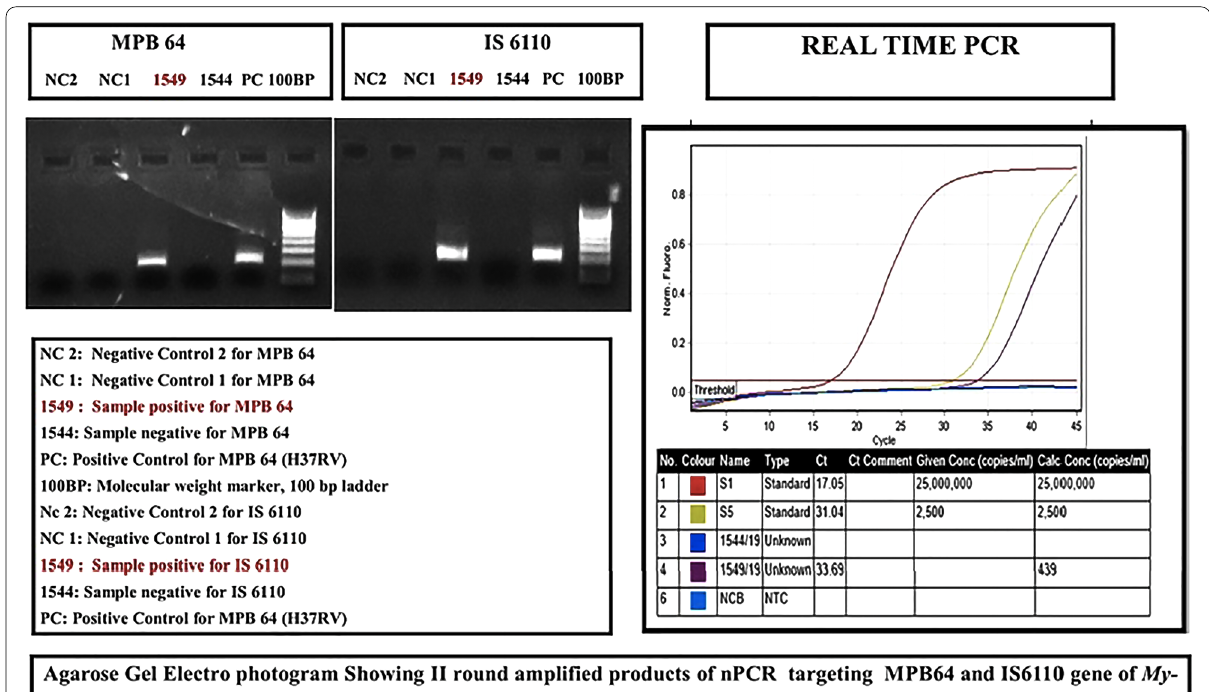
Fig. 4 Vitreous sample of a patient which showed positive results in Nested and Real-time PCR for